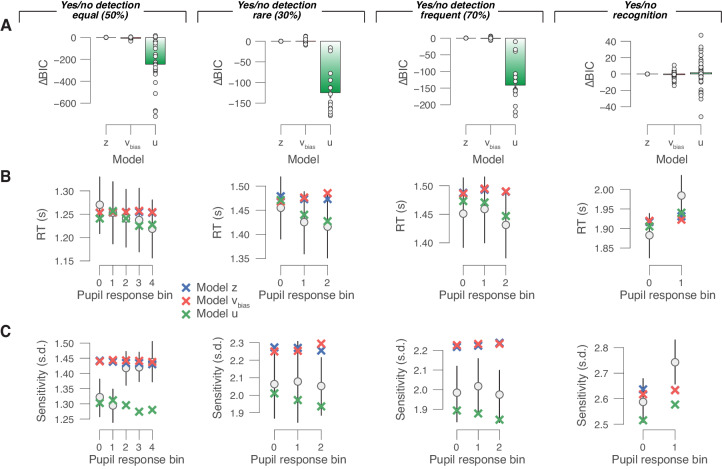
Comparison between fits of models with or without varying urgency.(A) For each forced-choice yes/no data set (from left to right), we compared the BIC values for three different models (see main text; see 'Materials and methods'). The BIC for the starting point model was used as a baseline for each dataset. Lower BIC values indicate a model that is better able to explain the data, taking into account the model complexity; a BIC of 10 is generally taken as a threshold for considering one model to be a sufficiently better fit. Data points are for individual subjects. The urgency model provided the best fit. We reasoned, however, that the best overall model in terms of BIC does not necessarily best explain the behavioral correlates of pupil-linked phasic arousal. To investigate this, we refitted the urgency model, and now let urgency vary with a number of randomly defined (within subject) bins. This ‘random’ urgency model again outperformed the starting point and drift bias models (all mean BIC across subjects < −10). This suggest that the urgency model’s goodness of fit is due to the powerful effect that the urgency has on the overall RT distribution (irrespective of pupil). Specifically, it can cut off the long tail in the RT distribution of the DDM, which agrees with the overall empirical RT distributions of the yes/no detection datasets (Figure 4—figure supplement 1A). Indeed, the urgency model did accurately predict mean RT and sensitivity in each pupil bin [panels (B) and (C)], which probably resulted in the best goodness of fit in terms of BIC. (B) Residuals between empirical mean RT and model predictions (see 'Materials and methods'). Statistical difference was assessed by paired-sample t-tests. (C) As panel (B), but for sensitivity (d′). For panels (A–C), the data shown are group averages (N = 24, N = 15, N = 15 and N = 54); error bars are s.e.m.